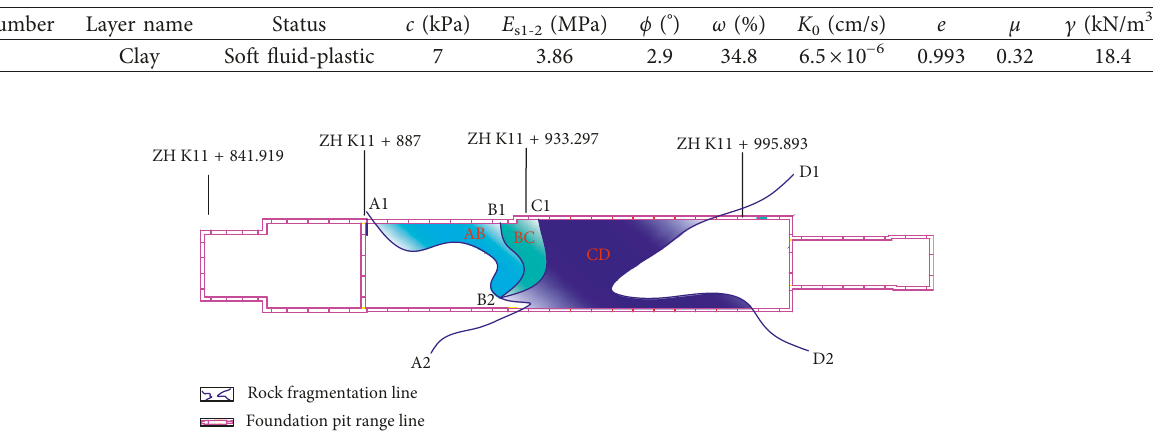
Figure 2: Result of comprehensive geophysical prospecting. Table 2: Grouting parameters of field test.